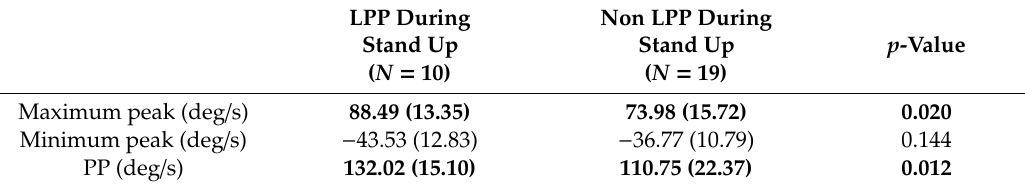
Figure A1. Wave forms and indices of angular velocity of lower trunk on the sagittal plane. Table A1. Value of angular velocity of trunk motion in the sagittal plane, according to the occurrence of lumbopelvic pain (LPP) in our previous research.